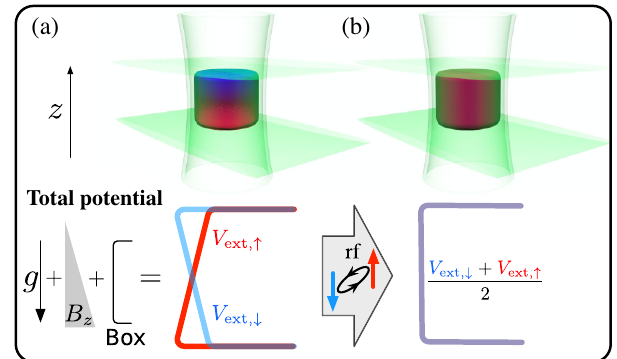
FIG. 1. Creating a uniform Fermi gas by periodic driving. (a) The gas, composed of two spin states (marked by red and blue and by opposite arrows), is trapped in a boxlike optical potential. The two spins have different magnetic dipole moments. As a result, it is possible to only partially counteract the gravitational potential with a magnetic-field set according to Eq. (3). The total external potential V depends on the spin s ∈ f ↑ ; ↓ g , and, ext ;s consequently, the density distribution of each spin is different and not uniform (color gradient in the top left figure). (b) By adding a resonant rf field that drives rapid spin rotations, we create an effective spin-independent potential, in which the gas becomes homogeneous. Importantly, the intrinsic many-body behavior of the gas is unchanged by this